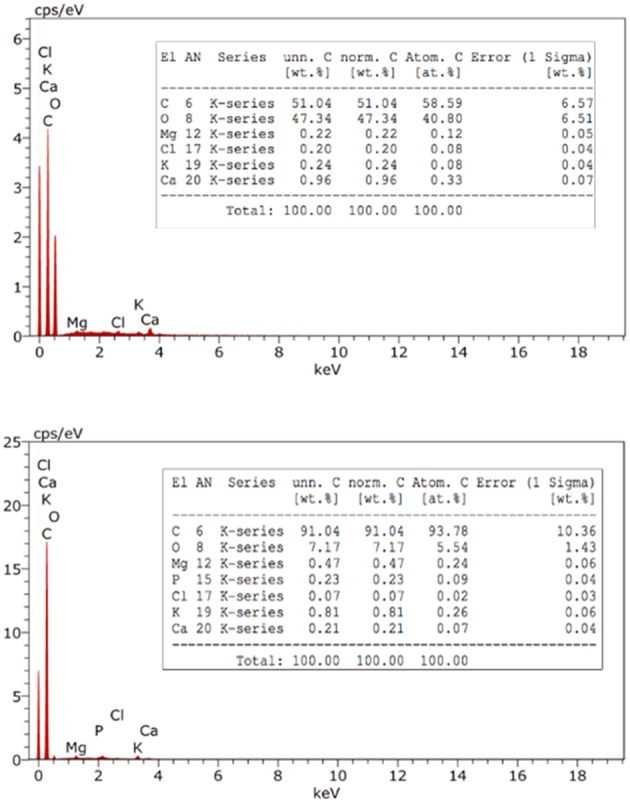
EDX analysis of RDP (upper panel) and BDP (lower panel).